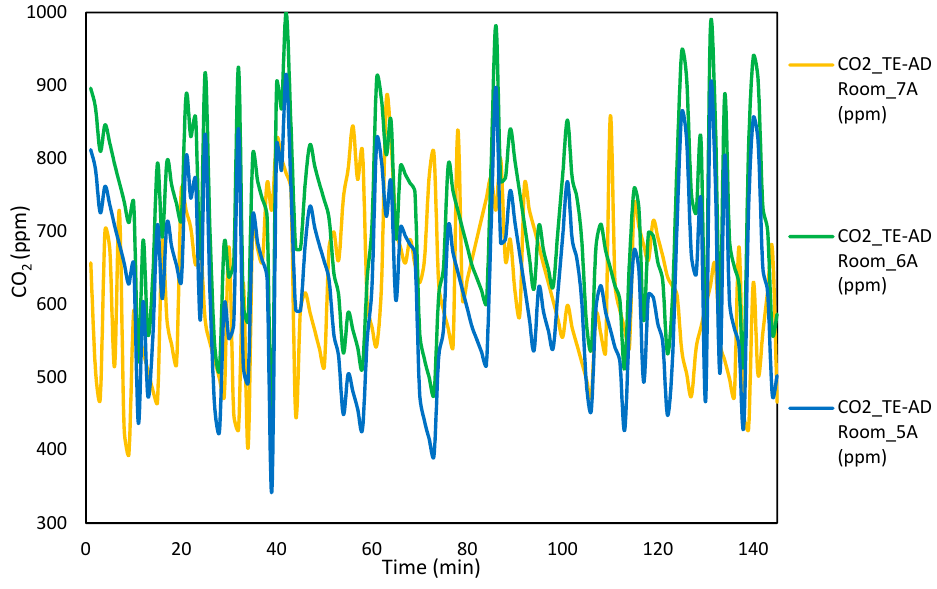
ff erent power inputs. 2 at di